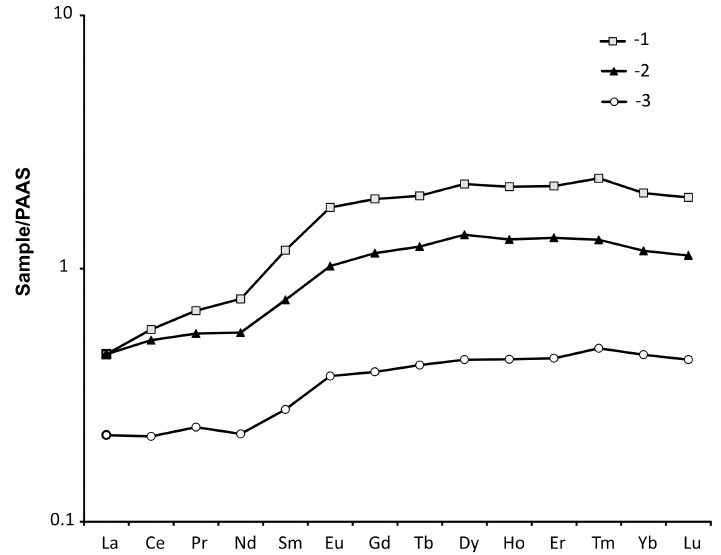
Figure 11. PAAS-normalised [75] REE patterns of fine-crystalline siderite (1), crystalline siderite (2), and ankerite (3) fractions from mud masses (Bulganak area).